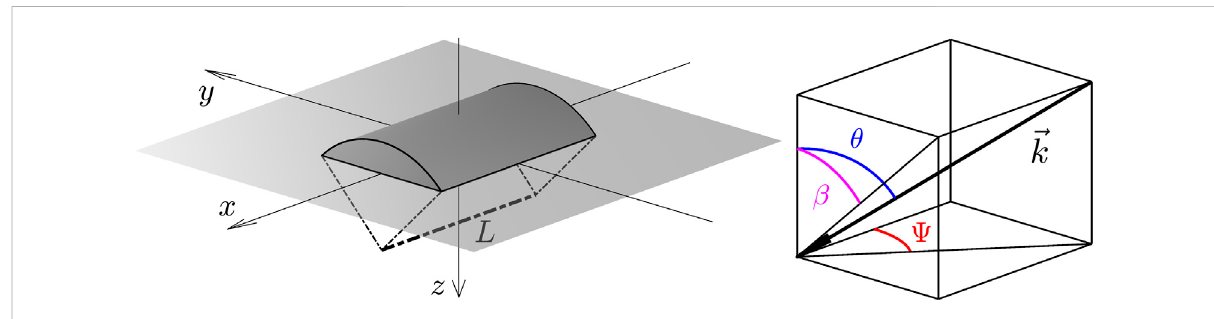
FIGURE 1 System ’ s geometry in the x − y − z